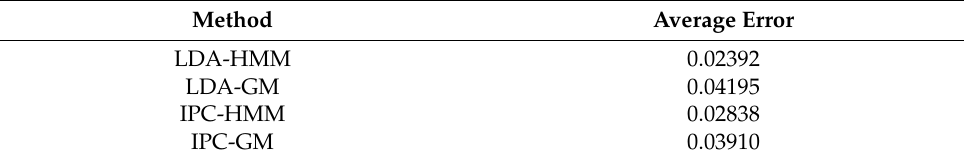
Table 2. Average error of each